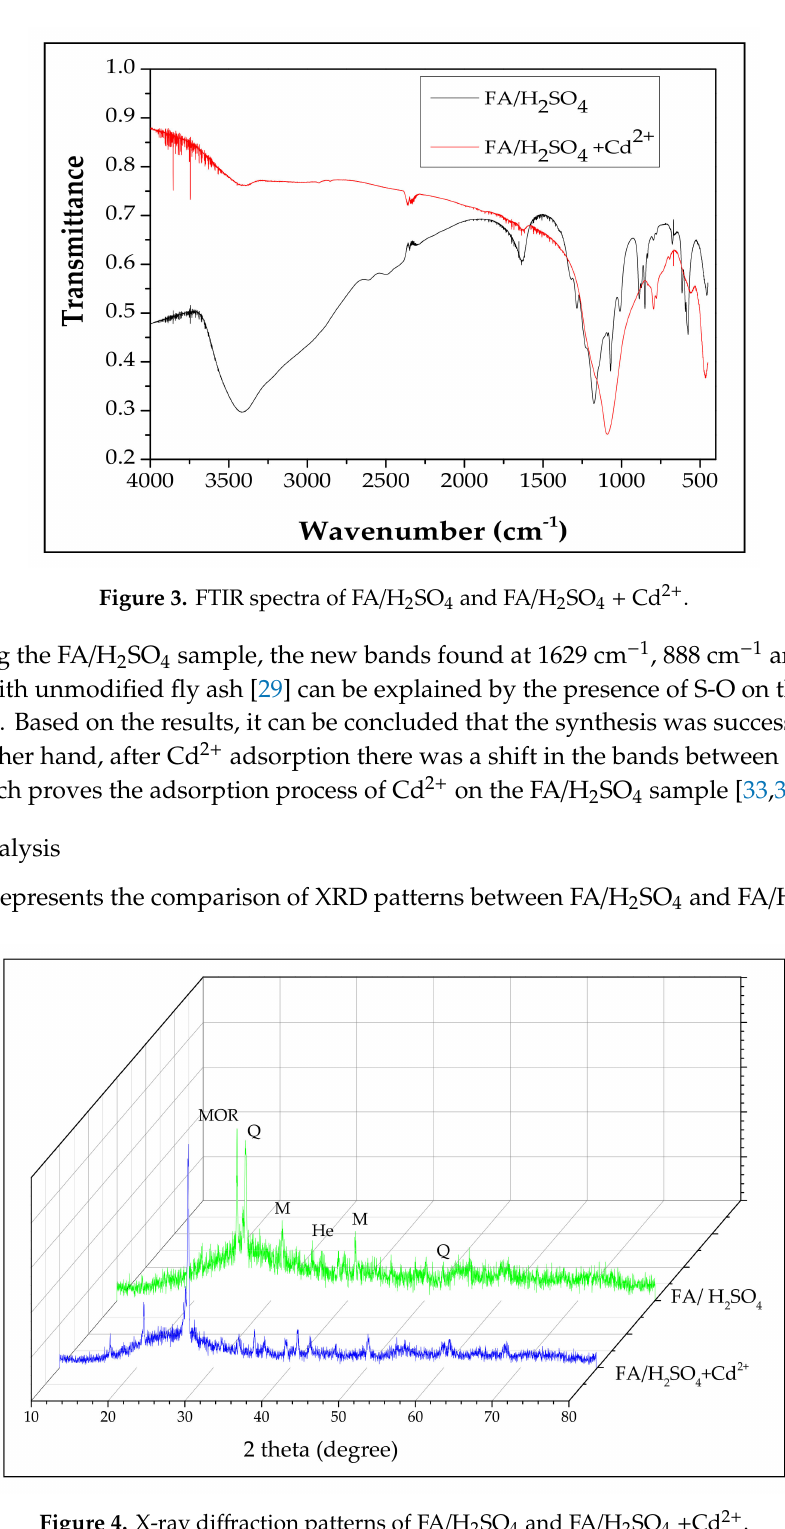
Figure 4. X-ray di ff raction patterns of FA / H 2 SO 4 and FA / H 2 SO 4 + Cd 2 +